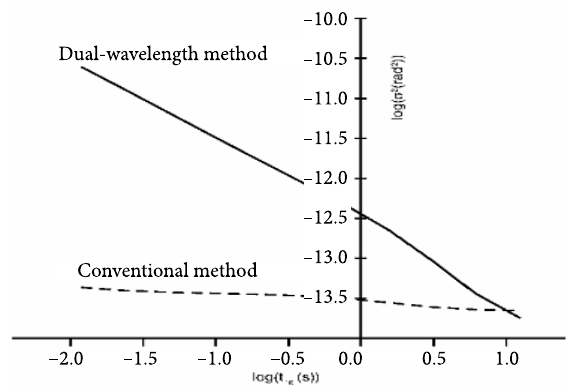
Fig. 9. Performance of the dispersion method (Böckem